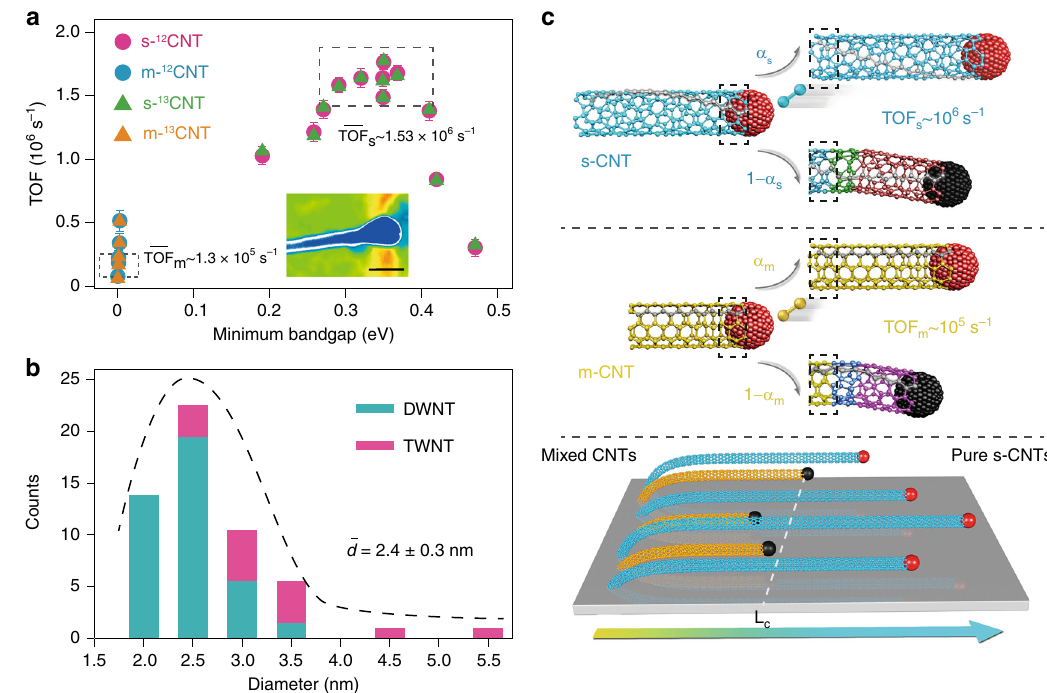
Fig. 3 Bandgap dependent dimer addition process. a Minimum bandgap (target layer) of concentric layers for few-walled CNTs versus TOF of the target layer. Detection of 12 C preceded 13 C signal veri fi ed the expected tip mode, also indicated by the AFM image on the tip of a long CNT (inset, scale bar, 10 nm). The errors come from the uncertainty of identifying the transition site. b Diameter distribution of CNTs longer than 154 mm. This reveals a